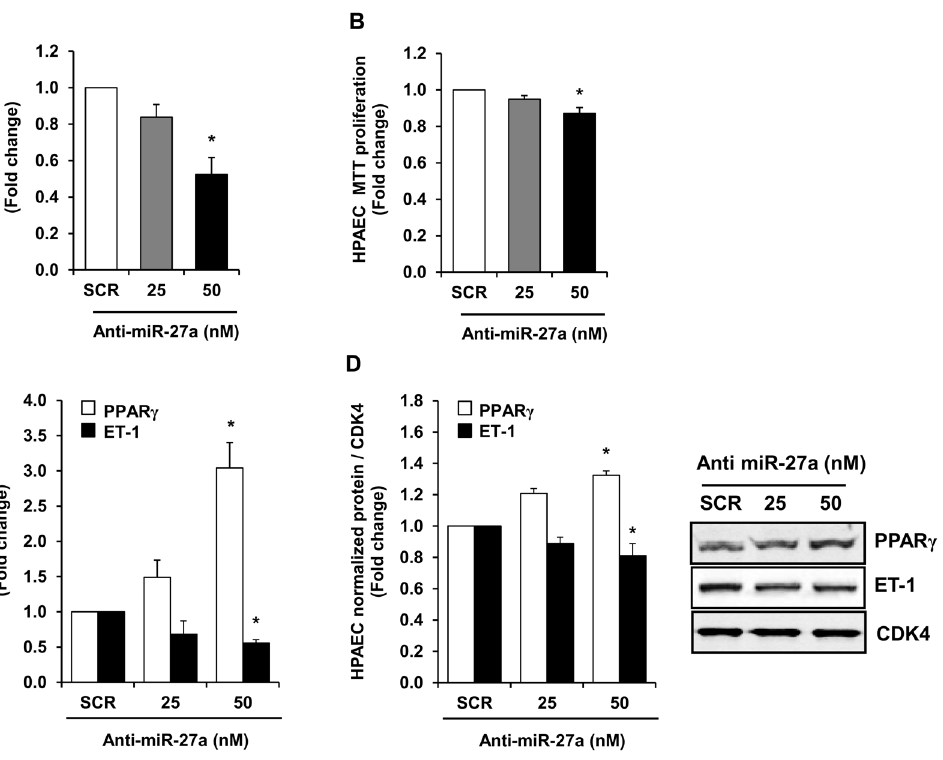
Figure 4. Anti-miR-27a reduced HPAEC miR-27a levels, HPAEC proliferation, and ET-1 levels and increased PPAR c expression. HPAECs were treated with either scrambled (SCR) or 25–50 nM anti-miR-27a for 72 hours. HPAEC were then collected, and RNA was isolated. qRT-PCR was performed for miR-27a, PPAR c , and ET-1 levels. Western blotting was employed to detect PPAR c and ET-1 protein levels. HPAEC proliferation was determined using MTT assays. Each bar represents the mean 6 SE miR-27a/RNU6B ( A ), proliferation ( B ), PPAR c or ET-1 mRNA relative to ribosomal S9 (9S RNA) ( C ), or PPAR c or ET-1 protein relative to CDK4 protein ( D ) expressed as fold-change vs. SCR. *p , 0.05 vs. scrambled (SCR) miRNA, n=3–5.